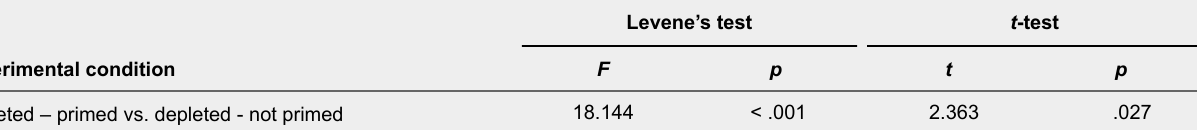
t-test Experiment